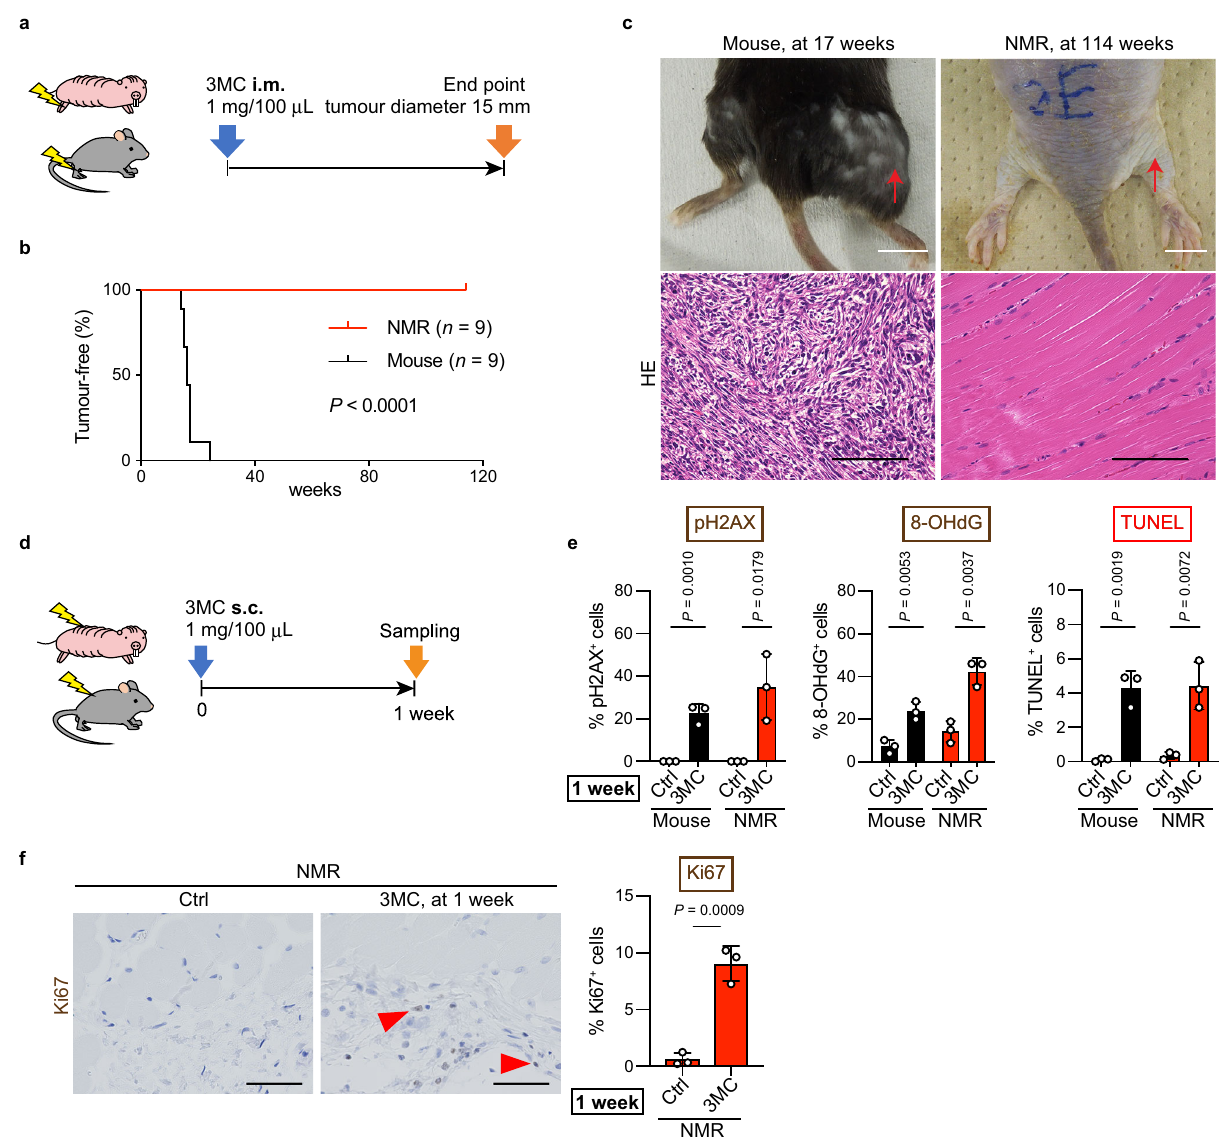
Fig. 1 Naked mole-rats (NMRs) do not develop 3-methylcholanthrene (3MC) -induced tumours despite the induction of cellular damage. a Schematic diagram for carcinogenesis induction by intramuscular (i.m.) injection of 1mg 3MC into the hind limb. b Kaplan – Meier curves of tumour-free mice and NMRs treated with 3MC. n = 9 animals per species. c Gross appearance and haematoxylin and eosin (HE) staining of a mouse tumour at 17 weeks and NMR muscle at 114 weeks after i.m. 3MC injection. Red arrows indicate injection sites. Scale bars: 1 cm (upper) and 50 μ m (lower). d Schematic diagram for investigating short-term responses to 3MC after subcutaneous (s.c.) injection into the back skin. e Quanti fi cation of phospho-Histone H2A.X (pH2AX)-, 8-hydroxy-2 ′ -deoxyguanosine (8-OHdG)-, and TUNEL-positive cells after s.c. 3MC-injection. f Immunohistochemical staining and quanti fi cation of Ki67- positive cells in NMR skin at 1 week after s.c. 3MC-injection. Red arrowheads show positive cells. Scale bar: 50 μ m. For quanti fi cation of ( e and f ), data are presented as the mean± SD of n = 3 animals. Log-rank test for ( b ). Unpaired t -test versus untreated control (Ctrl) for ( e and f